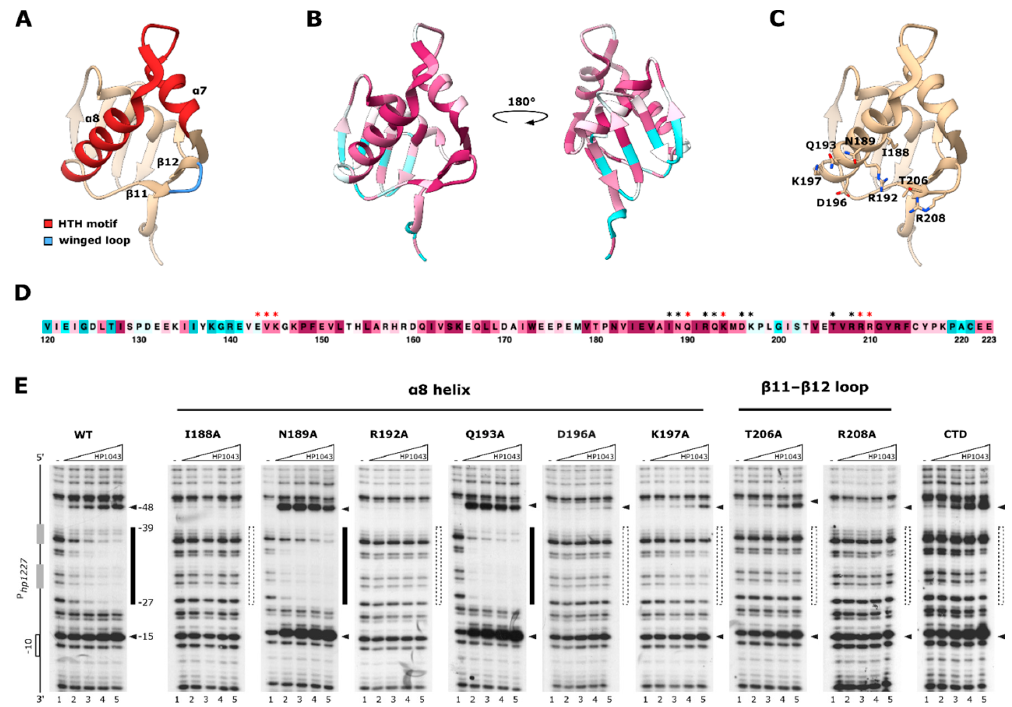
Figure 2. In vitro binding of wild-type and mutant HP1043 to P hp1227 . ( A – C ) DNA binding domain (DBD) of HP1043 depicted as ribbon (PDB: 2HQR). ( A ) Functional elements of the wHTH motif. The HP1043_DBD is depicted in tan. The HTH motif is highlighted in red, while the winged loop in light blue. ( B ) Evolutionary conservation analysis was performed using default settings of the ConSurf web server on the HP1043-DBD protein sequence. Residues are colored depending on their calculated conservation scores against homologs, on a scale of nine grades ranging from the most variable positions (grade 1) colored turquoise, through intermediately conserved positions (grade 5) colored white, to the most conserved positions (grade 9) colored maroon. ( C ) residues selected for alanine scanning mutagenesis are shown as stick and colored by heteroatom. ( D ) The protein sequence of the HP1043-DBD (residues 120–223) colored as in B. Asterisks indicate residues selected for the initial mutagenesis (in black) and confirmation of the docking model (in red). The color scheme used is the same as in panel B ( E ) DNase I footprinting experiments to investigate DNA binding properties of HP1043 point mutants or in the absence of the dimerization domain (CTD mutant). Experiments were performed as in Figure 1 except for HP1043 protein concentrations tested (0, 0.7, 2, 5.9, and 17.7 µM dimeric HP1043). Increasing HP1043 concentration is indicated as a triangle, absence of HP1043 in the reaction is indicated with “-”. On the left of the autoradiographic film, a schematic representation of P hp1227 , where the − 10 promoter element is depicted as an open box and the hemi-sites of the HP1043 consensus sequence as grey boxes. On the right of the footprint panels, the bars indicate the region DNase I protection on the target promoter, and the color represents the strength of interaction, with black representing strong binding, grey intermediate binding, and white loss of binding. Black arrowheads indicate DNase I hypersensitive sites. WT, wild-type HP1043 protein; I188A, N189A, R192A, Q193A, D196A, K197A, T206A, R208A, amino acid substitutions in the HP1043 protein; CTD, HP1043 mutant deprived of the dimerization domain, preserving the DNA-binding domain (residues 119–223).